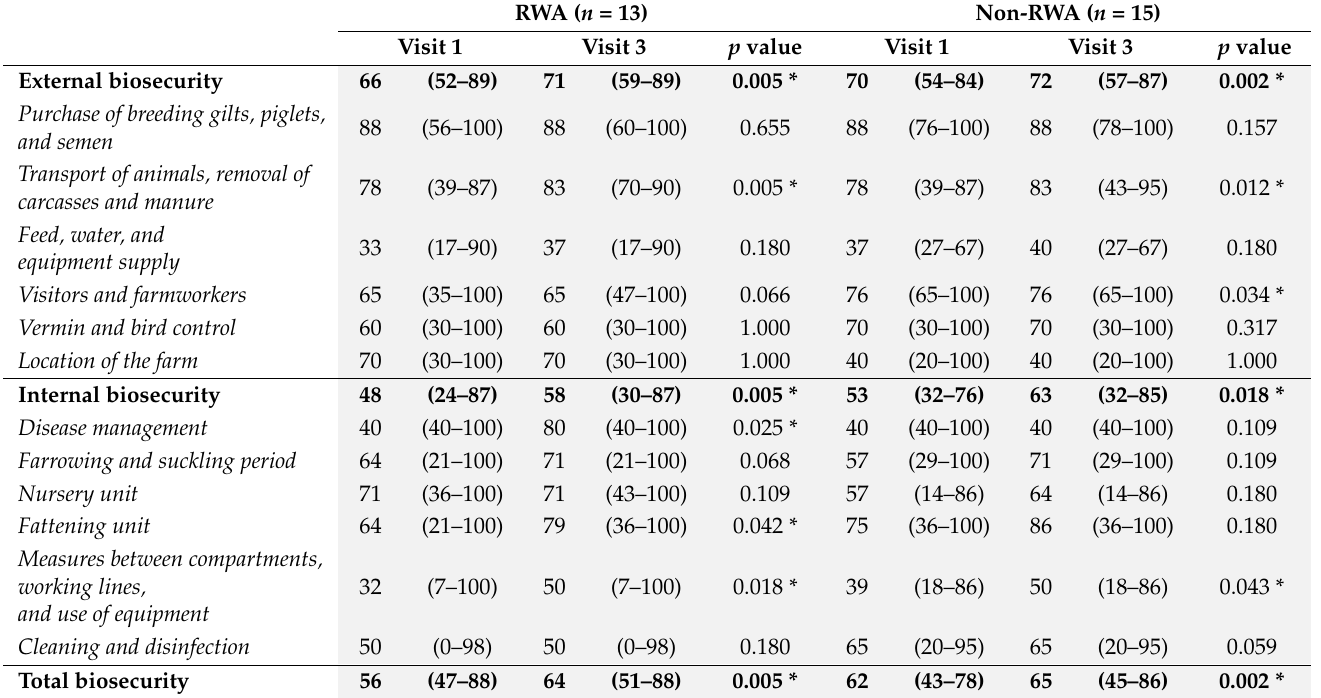
Table 7. The median (min.–max.) biosecurity scores (%) of the farms for the different categories of the Biocheck.UGent TM survey for the Raised Without Antibiotics (RWA) ( n = 13) and the non-RWA pig farms ( n = 15). The survey was filled in during the first and third farm visit, jointly by the researcher and the farmer. p values are provided for a comparison between RWA and non-RWA farms based on a non-parametric Wilcoxon matched-pair signed-rank test.